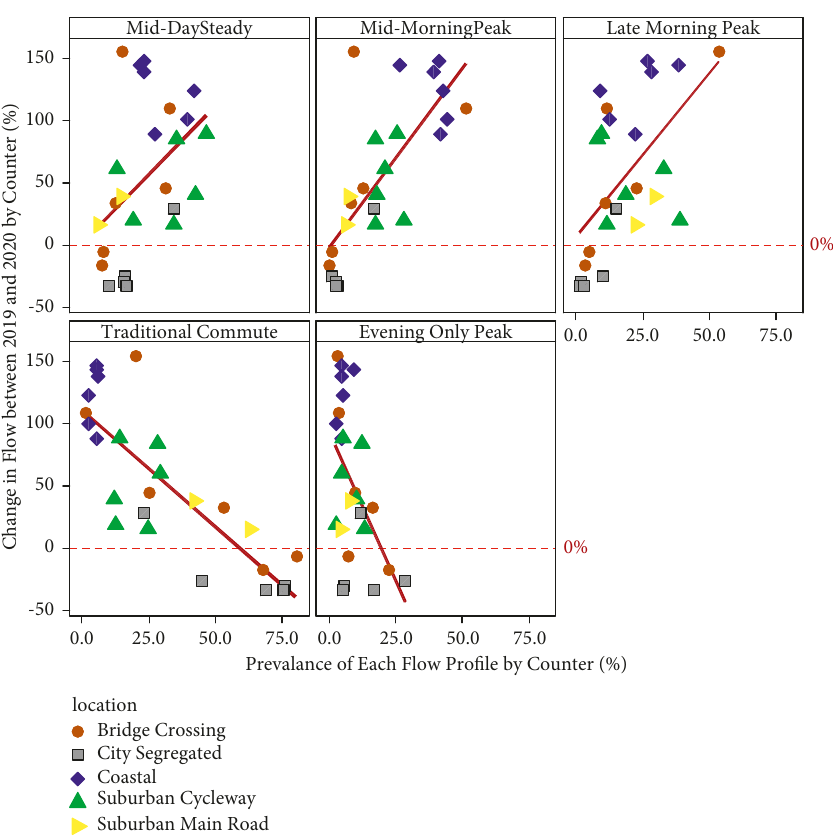
Figure 10: Cluster prevalence at each counter and the change in total Table 3: Correlation between cluster prevalence and change in flows from pre-COVID baseline (Mar–Aug) compared to 2020 (Mar–Aug).